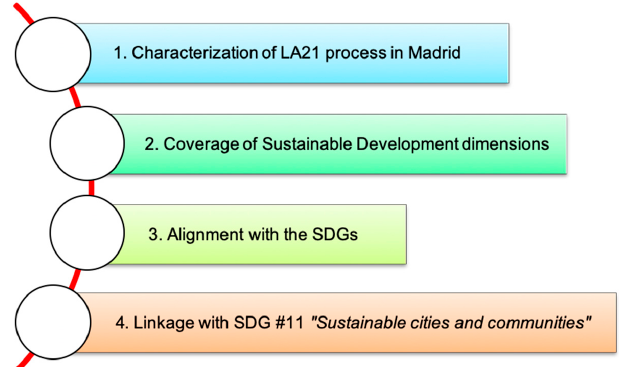
Figure 1. Methodology of the research (Source: author). SDGs: Sustainable Development Goals. LA21: Local Agenda 21. SDG # 11: Sustainable cities and communities.